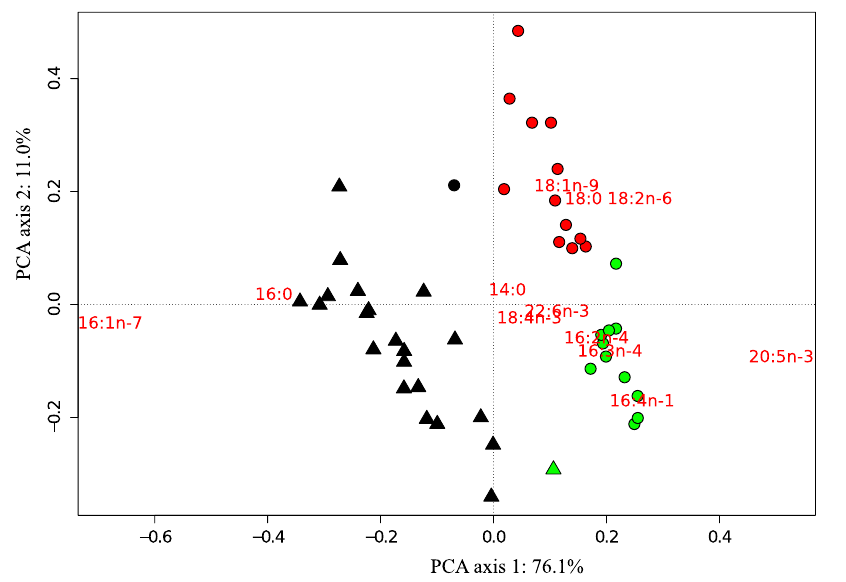
Figure 4. Principal component plot of fatty acid proportions (arcsin square root transformed) of C. centralis and ice algae. Colours correspond to the clusters identified in Fig. 4; black indicates cluster 1, red is cluster 2 and green is cluster 3. Fatty acid vectors are scaled proportional to eigenvalues while samples are unscaled.